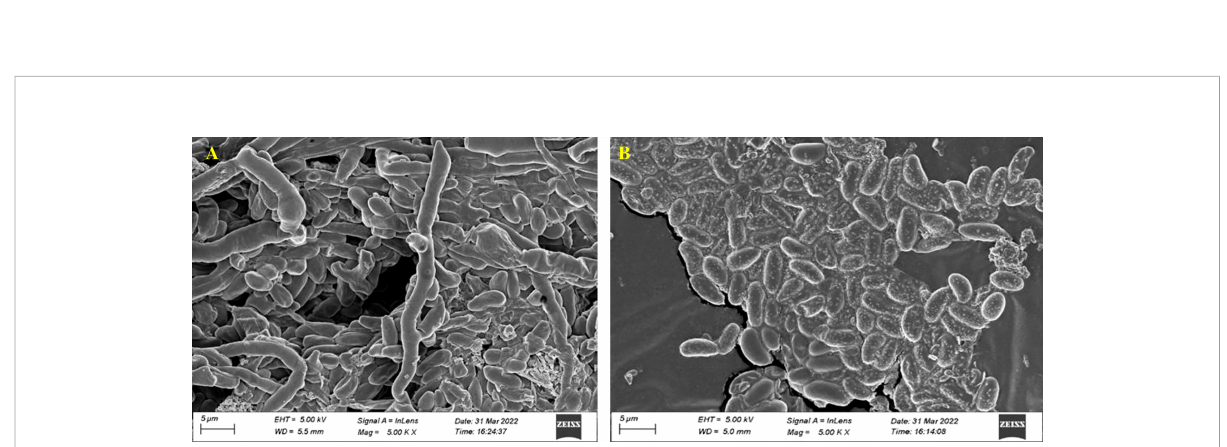
FIGURE 6 Fungal morphology of F oxysporum (MTCC 284) affected by Streptomyces . sp. VCLA3 under Scanning Electron Microscope (SEM). (A) Control, (B) Treatment.